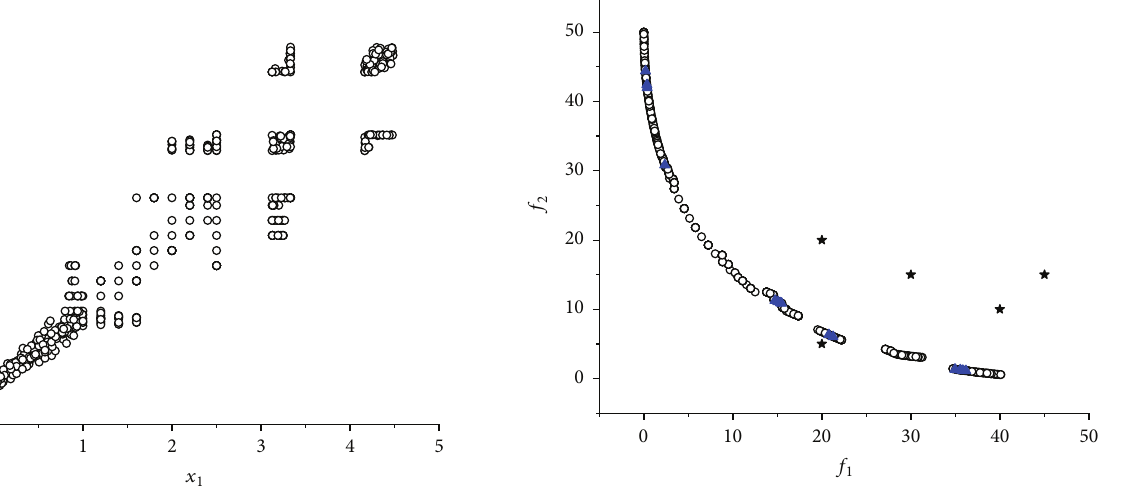
Figure 1: The obtained nondominated solutions of M-BINH prob- lem, projected in decision space.